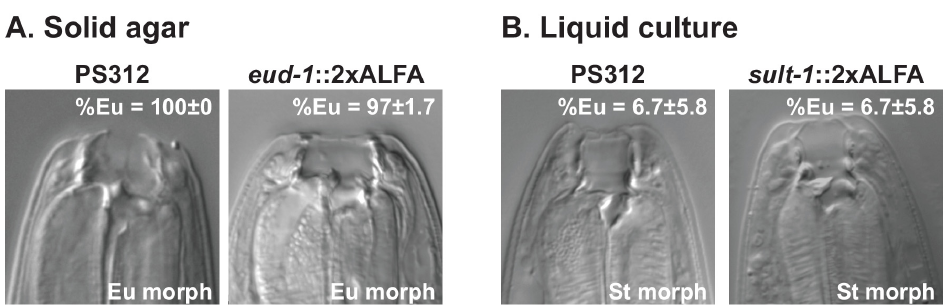
Figure 1. EUD-1 and SULT-1 ALFA tagging in P. pacificus ( A , B ) Images depicting the eurystomatous (Eu) ( A ) or stenostomatous (St) ( B ) morphs of PS312, eud-1 ::2xALFA and sult-1 ::2xALFA animals grown on agar plates ( A ) and liquid cultures ( B ). Eu worms have a wide-mouth with two teeth. The bacterial feeding St worms show a narrow mouth with a single tooth. The numbers in the images represent the mean value ± the standard deviation of mouth–form ratio in the different environmental conditions and worm strains presented as percent Eu (%